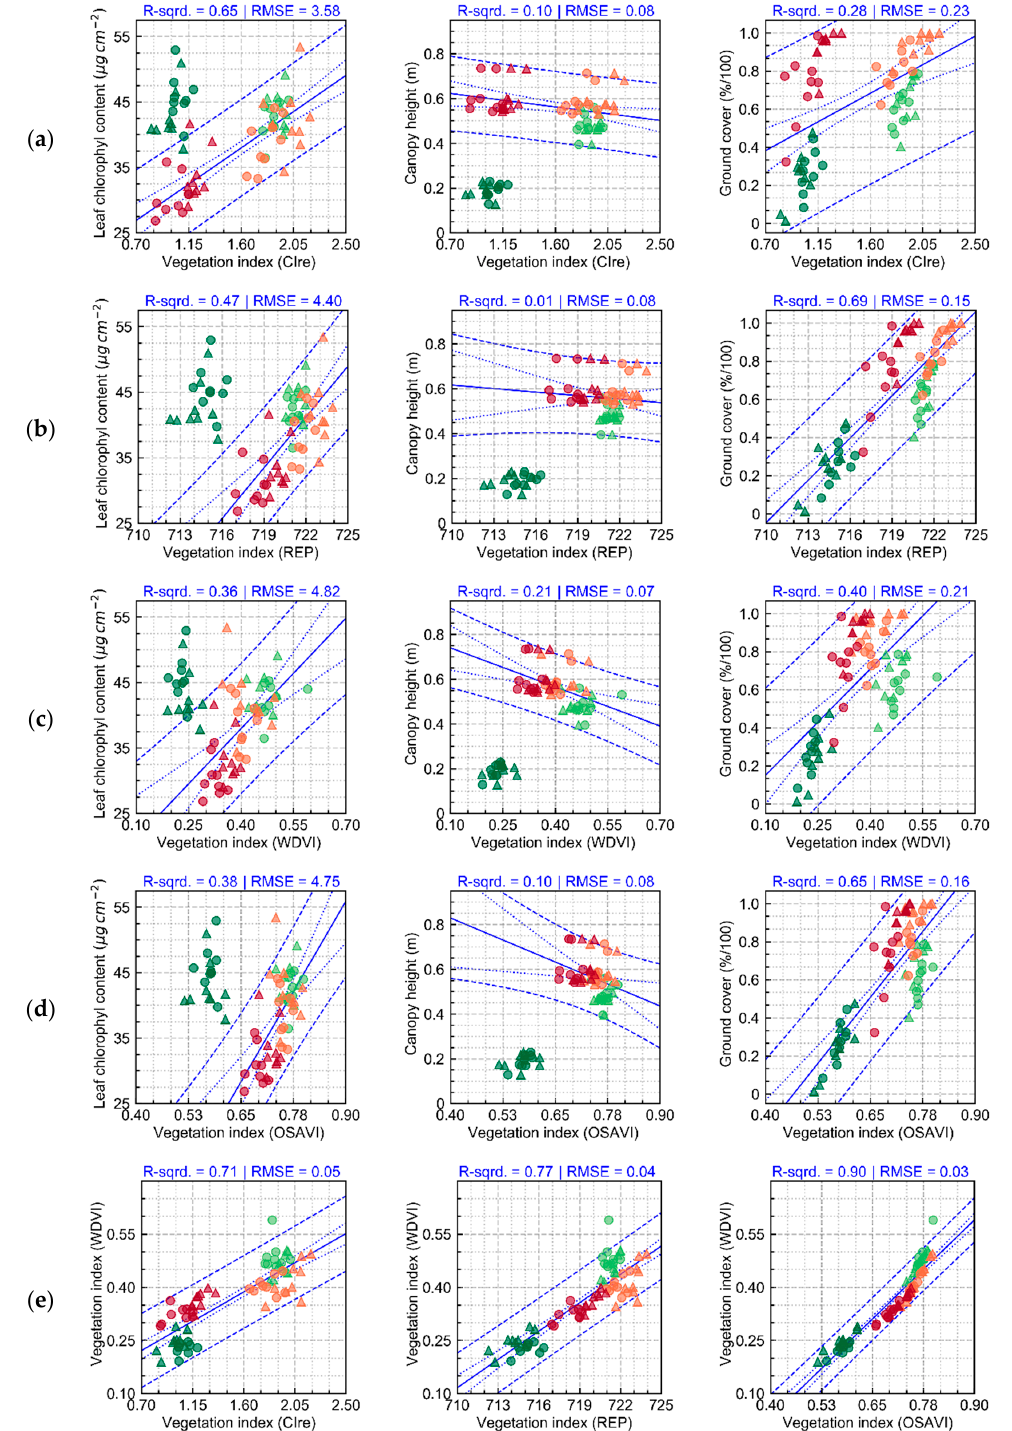
Figure A3. Linear regression (fitted by ordinary least squares) between crop traits and vegetation indices (VIs = CIre, REP, WDVI, and OSAVI; a – d ) and between WDVI and other VIs ( e ). Prediction and confidence intervals (95%) are presented in blue dashed lines. Colors from green to red indicate time of acquisition (from 37 to 78 DAS). Dots and triangles correspond to the non-mixed and mixed cropping system, respectively. Only the last three acquisitions are taken into account for evaluating the relationship between traits and VIS ( a – d ), all the data are considered for the comparison between WDVI and other VIs ( e